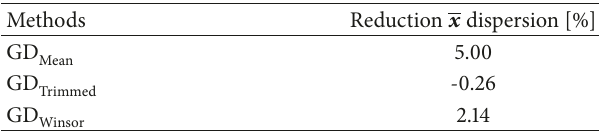
Table 31: Exponential with 50 points.